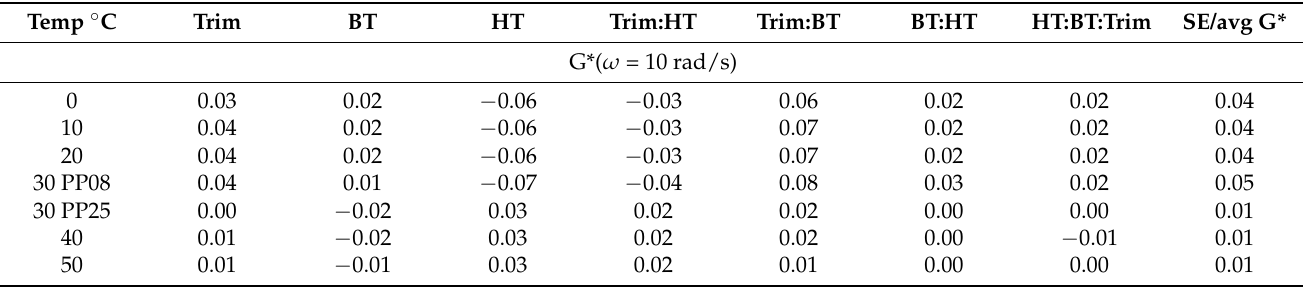
Table 7. Effect estimates and Standard Errors (SE) for 70/100. The significant effects with a 95% confidence interval are shown in